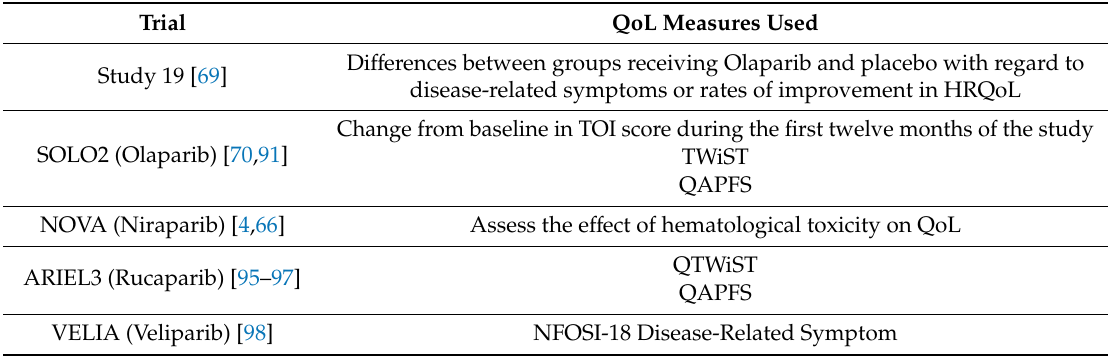
Table 2. Comparisons and contrasts of QoL measures in trials involving PARP inhibitors as maintenance in platinum-sensitive recurrent ovarian cancer